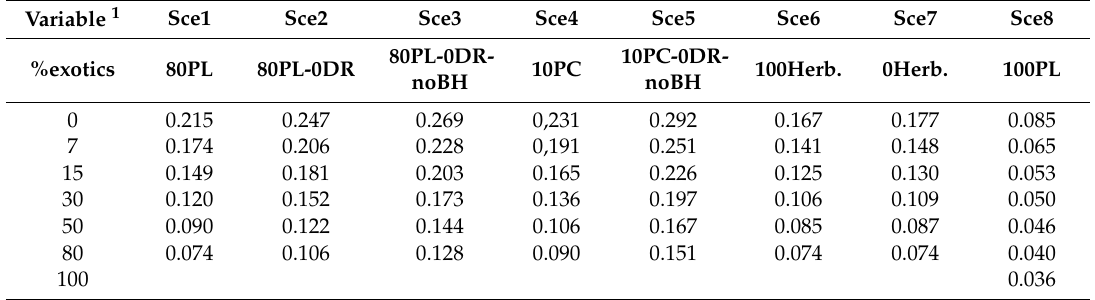
Table 11. Extreme scenarios’ results. See also Table 7 for a detailed scenario